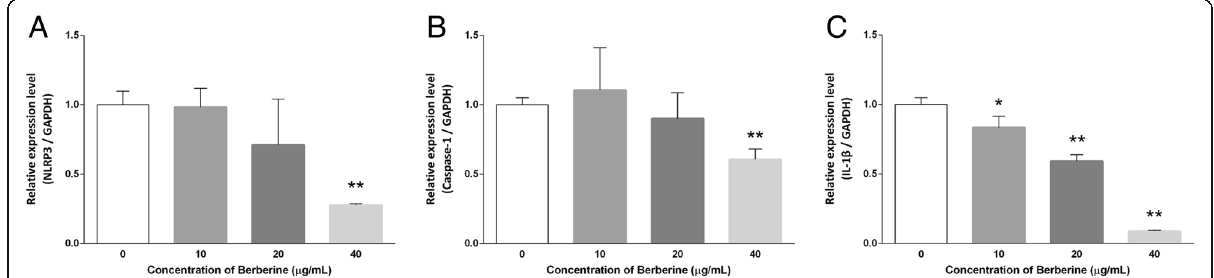
Fig. 5 Expression profile of NLRP3 inflammasome related gene in MDA-MB-231 cells treated with BBR. After treatment with various concentrations of BBR for 48h, the expression profile of NLRP3 inflammasome related gene, ( a ) NLRP3, ( b ) Caspase-1, and ( c ) IL-1 β , was analyzed using real-time PCR. Results are shown as the mean±S.D. from three independent experiments. Significant difference between control and treatment with BBR are shown, * p <0.05, ** p